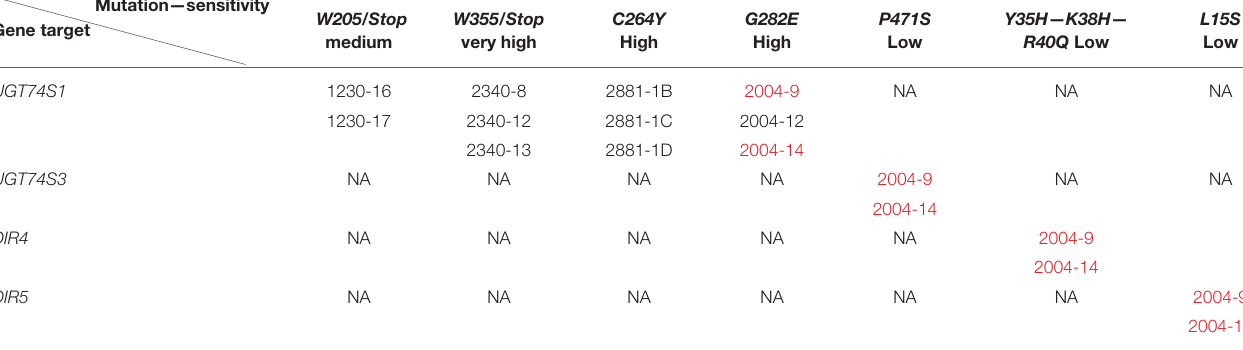
TABLE 5 | Mutations confirmed in UGT74S1 or identified in other genes by Ampliseq sequencing. Mutation—sensitivity W205/Stop W355/Stop C264Y G282E P471S Y35H — K38H — L15S Gene target R40Q Low medium very high High High Low Low UGT74S1 1230-16 2340-8 2881-1B 2004-9 NA NA NA 1230-17 2340-12 2881-1C 2004-12 2340-13 2881-1D 2004-14 UGT74S3 NA NA NA NA 2004-9 NA NA 2004-14 DIR4 NA NA NA NA NA 2004-9 2004-14 DIR5 NA NA NA NA NA NA 2004-9 2004-14 Lines in which mutations were found are shown and indicated by EMS family number (four Arabic numbers) followed by a dash and line numbers (1 or 2 digits arabic or alpha numeric numbers). NA, not applicable: indicates that no such mutation was found in that gene. The two lines 2004-9 and 2004-14 from family 2004 and carrying mutations in more than one genes are highlighted in red.